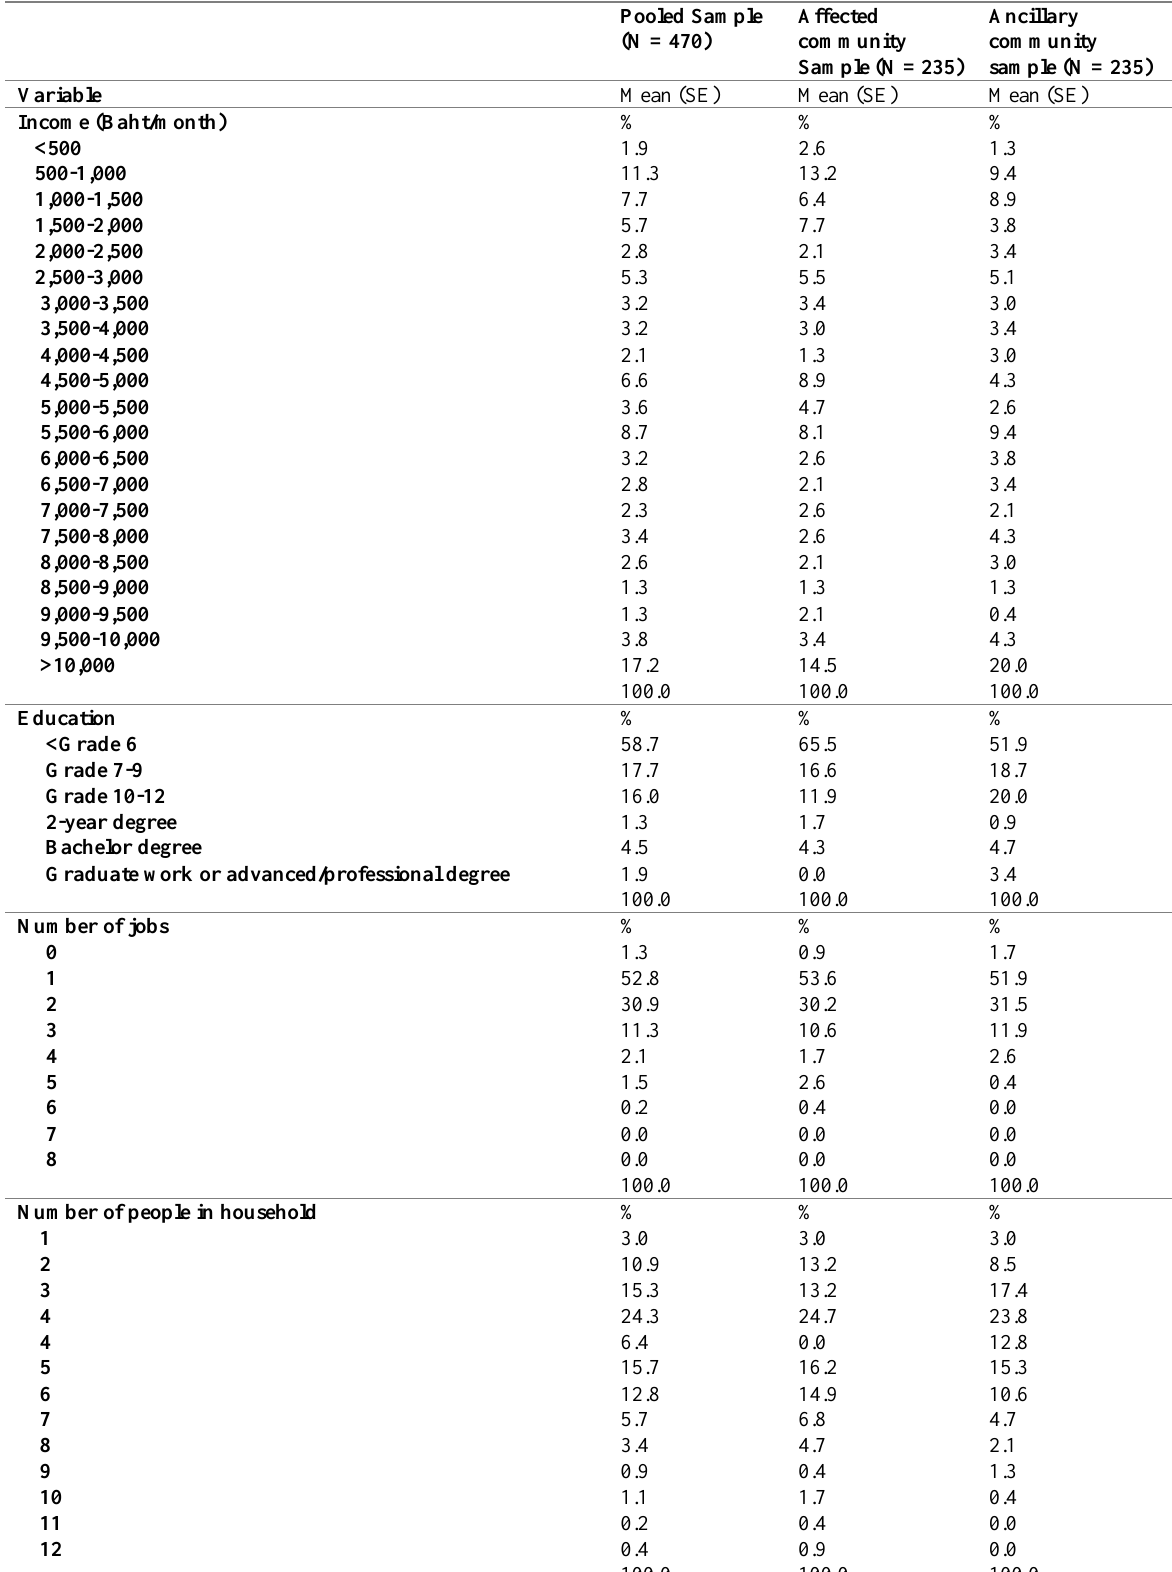
Table 3: Demographic Characteristics of Sample for Impacted and Non-impacted Communities